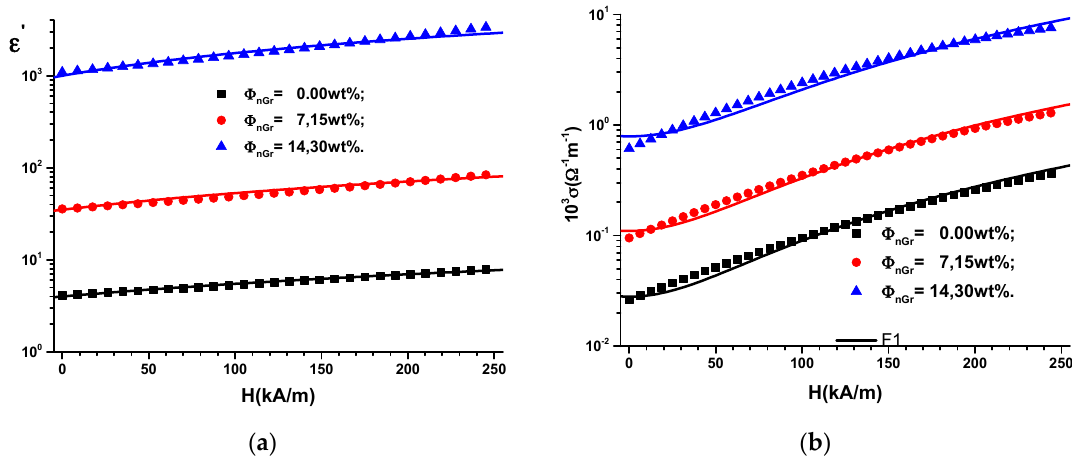
Figure 3. ( a ) Relative dielectric permittivity ε ’; ( b ) electrical conductivity σ as function of intensity H of the magnetic field and mass fractions Φ nGr of graphene nanoparticles (dots = experimental data, lines = theoretical result).